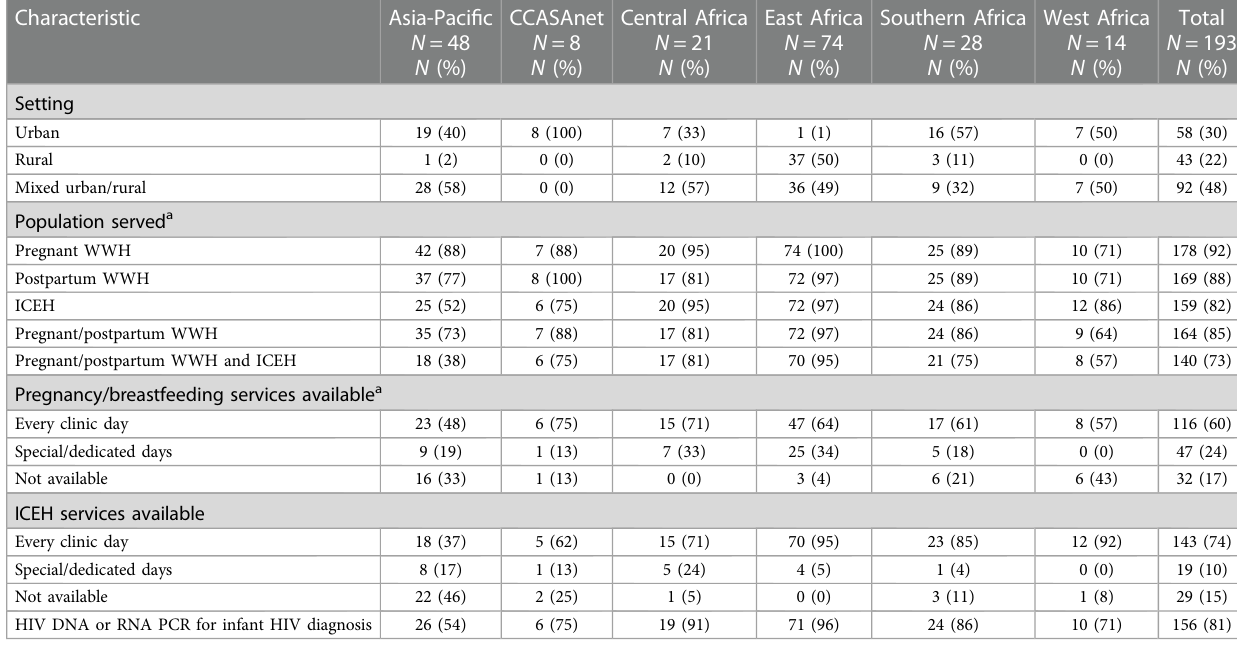
TABLE 1 Characteristics of service delivery for pregnant and postpartum women with HIV and infants with perinatal HIV exposure, by IeDEA region, September 2020 to March 2021. Characteristic